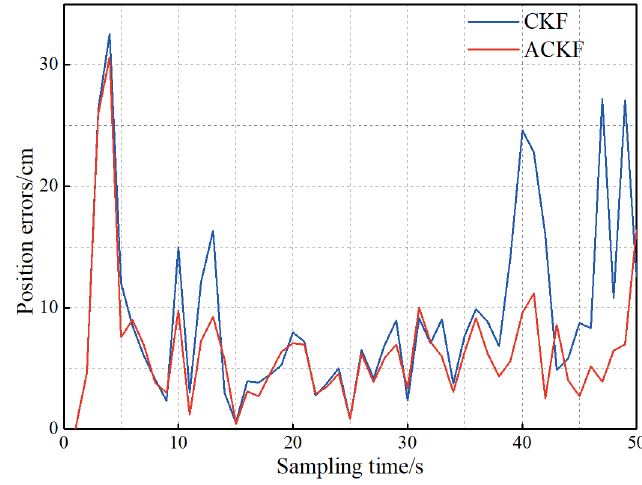
Figure 7. The influence of adaptive filtering on positioning accuracy.